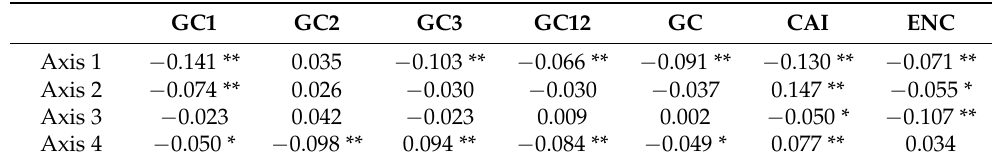
Table 2. The correlation coefficients between the axes and codon usage indices of chloroplast genes in 36 subg. Cerasus species.